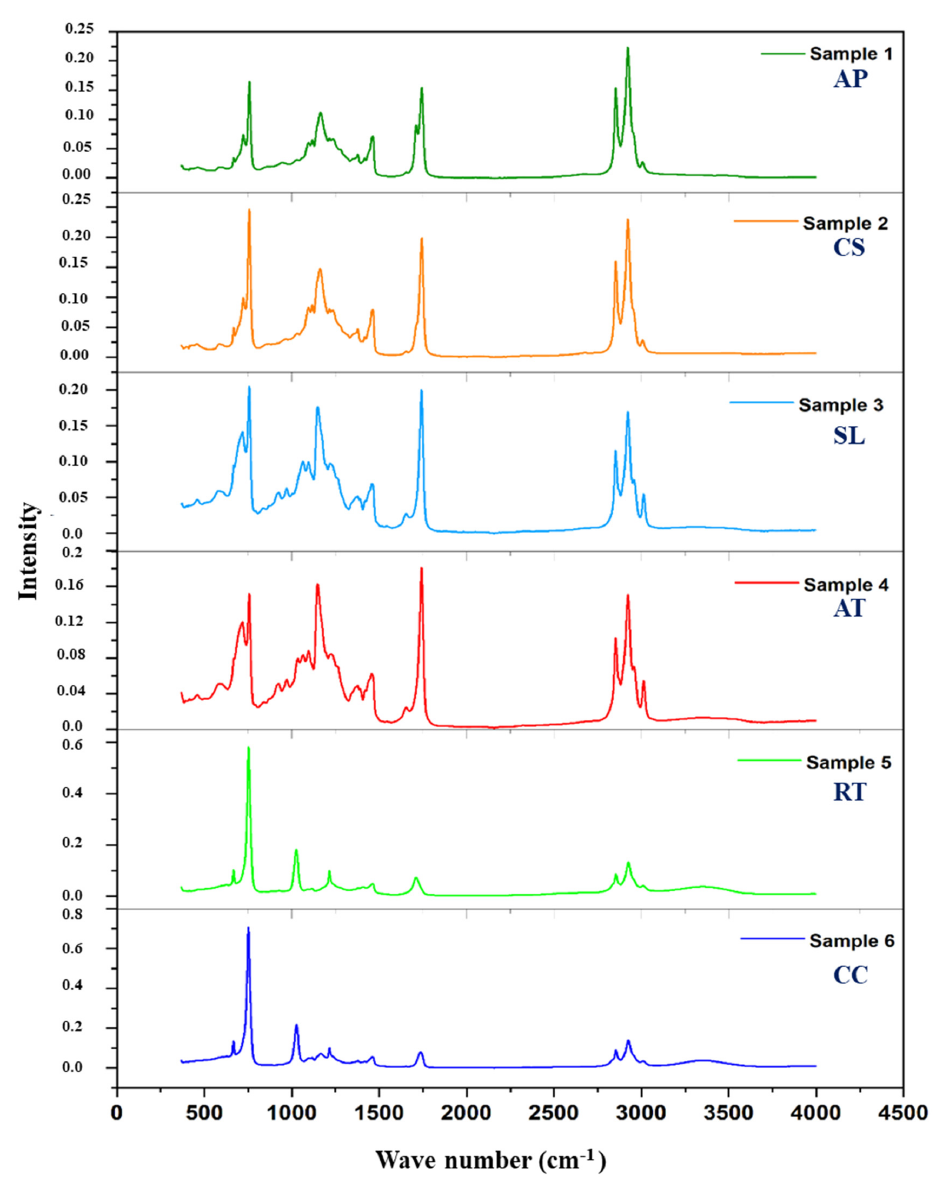
Figure 3. IR spectra of microbial oils such as A. protothecoides (AP) and C. sorokiniana (CS); thraustochytrids S. limacinum (SL) and Aurantiochytrium sp. T66 (AT); and yeasts R. toruloides (RT) and C. curvatus (CC).